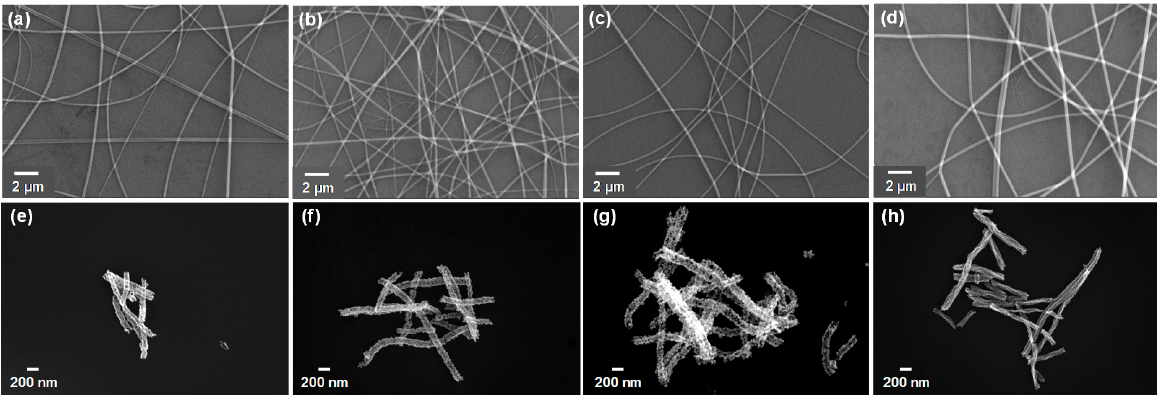
Figure 2. SEM images of ( a ) pristine SnO 2 /PVP, ( b ) SnO 2 /ZnO/PVP-1, ( c ) SnO 2 /ZnO/PVP-2, ( d ) SnO 2 /ZnO/PVP-3 before calcination. ( e – h ) Corresponding SEM images of porous hollow SnO 2 , SnO 2 /ZnO-1, SnO 2 /ZnO-2, SnO 2 /ZnO-3 nanofibers after calcination, respectively.